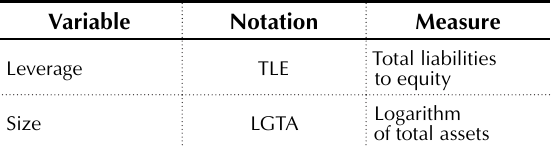
Table 7. Control variables